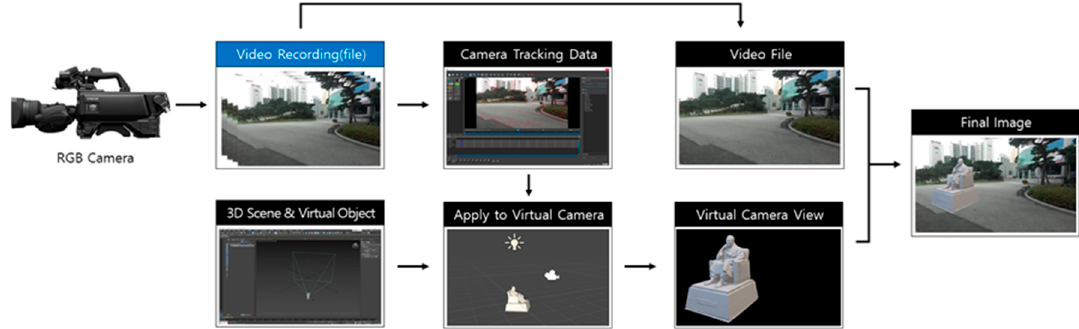
Figure 1. The traditional process using camera-tracking software (Boujou, After Effects) for creating a 3D composition by extracting feature points and estimating camera trajectory from video frames. The blue box shows the recording step (production) and the black boxes show the post-recording steps (post-production).